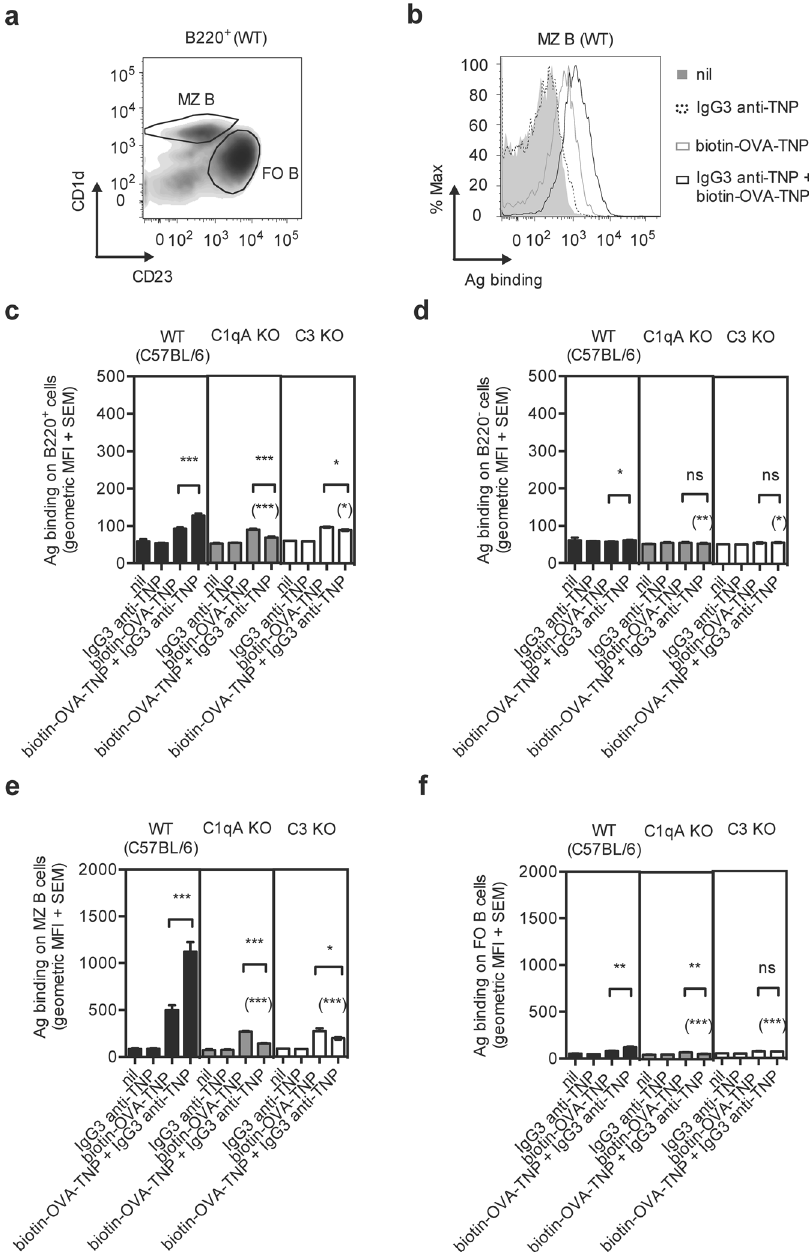
Figure 1. IgG3 increases binding of antigen to MZ B cells in WT, but not in C1qA or C3 KO mice. WT (C57BL/6), C1qA KO, and C3 KO mice were immunized with 50 μ g IgG3 anti-TNP (clone IM-F10) alone (n = 1–2), 150 μ g biotin-OVA-TNP (n = 5), a mixture of 50 μ g IgG3 anti-TNP and 150 μ g biotin-OVA-TNP (n = 5), or left unimmunized (nil, n = 1–2). Spleens were harvested 2 h after immunization and single cell suspensions were prepared from half of each spleen. Cells were stained with anti-mouse B220-Pacific Blue, anti- mouse CD23-PE, anti-mouse CD1d-FITC, and SA-APC. ( a ) Representative density plot of WT B220 + cells. MZ B cells were gated as B220 + CD23 lo CD1d hi and FO B cells as B220 + CD23 hi CD1d lo . ( b ) Representative histograms showing binding of antigen to MZ B cells in WT mice immunized with IgG3 anti-TNP + biotin- OVA-TNP (black line), IgG3 anti-TNP (dotted line), biotin-OVA-TNP (grey line), or left unimmunized (nil, grey area). The geometric means of fluorescence intensity (MFI) + SEM of antigen bound to ( c ) total B220 + cells, ( d ) B220 − cells, ( e ) MZ B cells, or ( f ) FO B cells in WT, C1qA KO, and C3 KO mice are shown. Data are representative of three independent experiments (two with the IgG3 clone IM-F10 and one with IM-H11). The p values for comparisons of the responses in mice immunized with antigen alone or IgG3-antigen complexes are indicated without parentheses. The p values for comparisons of responses in WT versus C1qA or C3 KO mice immunized with IgG3-antigen complexes are indicated within parentheses. ns, p > 0.05; * p < 0.05; ** p < 0.01; *** p <